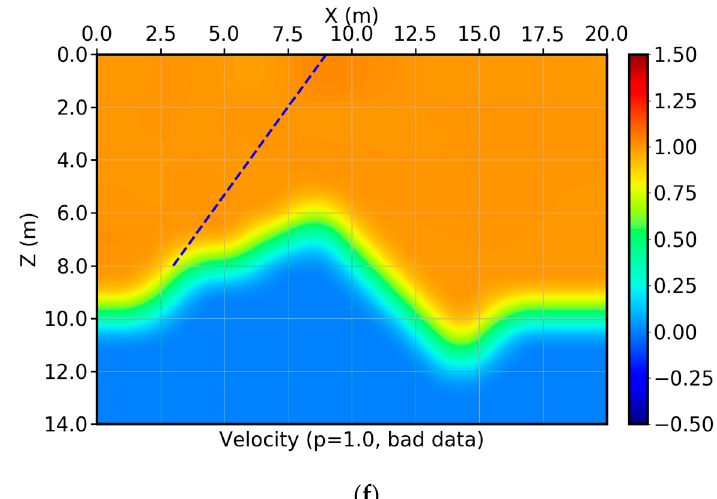
Figure 4. Velocity inversion using travel time information under high-frequency assumption. The blue line indicates the source-receiver pair where the travel time value has the wrong measurement, the source at (3, 8) m, and the receiver is at (9, 0) m. ( a ) The model grids and straight rays between source-receiver pairs. ( b ) The inversion results using perfect data with p = 2.0. ( c–f ), Inversion result using the wrong data with p = 1.3, 1.2, 1.1, and 1.0, respectively.